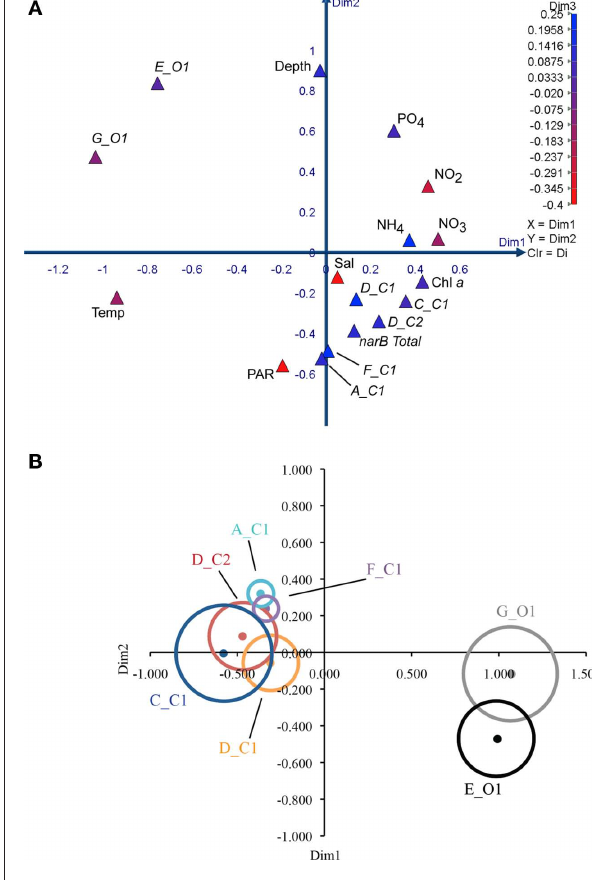
FiguRe 9 | Multi-dimensional scaling plots of environmental variables and narB subgroup abundances from CN207 samples. Spearman similarity matrices were used to construct the MDS plots. All data used is from the DCM and above, and were log ( x + 1) transformed before any analysis. narB subgroup abundance variables are italicized while environmental variables are not. (A) 3D plot of environmental and abundance variables, with the third dimension being represented by color (Kruskal’s stress = 0.08). (B) 2D MDS bubble plot of narB subgroup abundances (dots) and their respective correlation coefficients in relation to nitrate (bubbles; Kruskal’s stress = 0.04). A Spearman similarity matrix that contained only subgroup abundance data [same as in 9 (A) ] was used to construct the plot. Bubbles are scaled so that their width equates to the Spearman correlation coefficient value between the abundance of the respective subgroup and nitrate. All correlation coefficient values were significant ( p < 0.05) except for subgroups A_C1 and F_C1